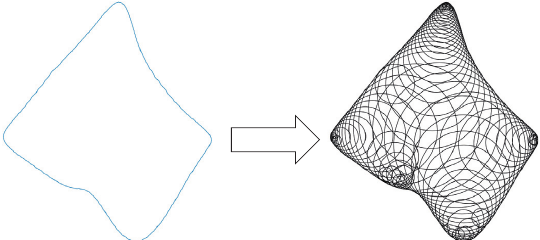
Figure 14: A DEM-simulated virtual particle from a Fourier-based particle